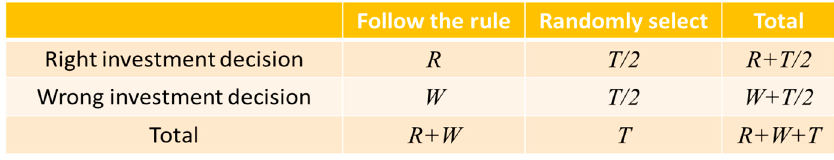
Figure 3. Observed frequencies: f o.